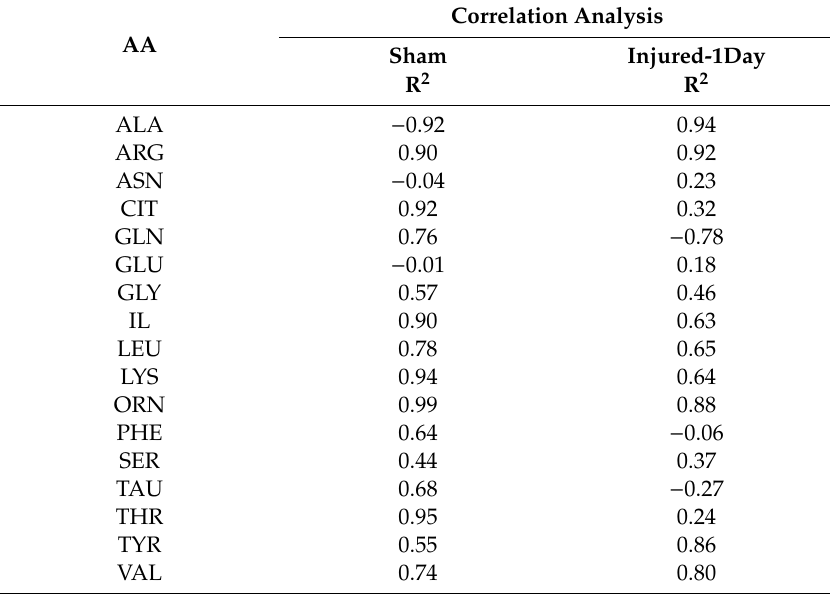
Table 5. The correlation coe ffi cients (R 2 ) between serum and brain tissue concentrations of seventeen amino acids for both healthy / sham and TBI group (24-h post-TBI). Correlation Analysis AA Sham Injured-1Day R 2 ALA −